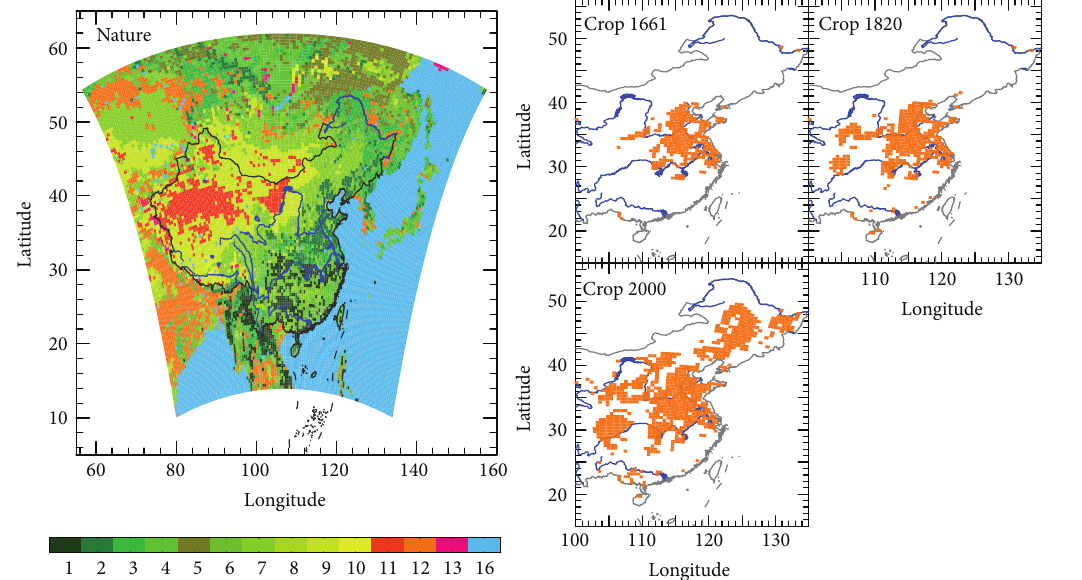
Figure 1: Natural vegetation in the simulation domain and cropland cells in Eastern China in 1661, 1820, and 2000 (the colorbar corresponds to the following: 1 broadleaf-evergreen tree; 2 broadleaf-deciduous trees; 3 broadleaf and needleleaf trees; 4 needleleaf-evergreen trees; 5 needleleaf-deciduous trees; 6 broadleaf trees with groundcover; 7 groundcovers only; 8 broadleaf shrubs with perennial groundcover; 9 broadleaf shrubs with bare soil; 10 broadleaf shrubs with ground cover; 11 bare soils; 12 croplands; 16 water